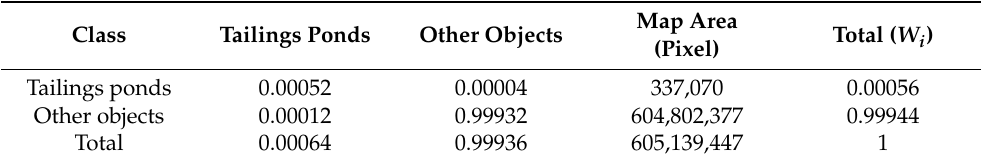
Table 3. The error matrix based on the estimated proportions of areas W i is the proportion of area mapped as class